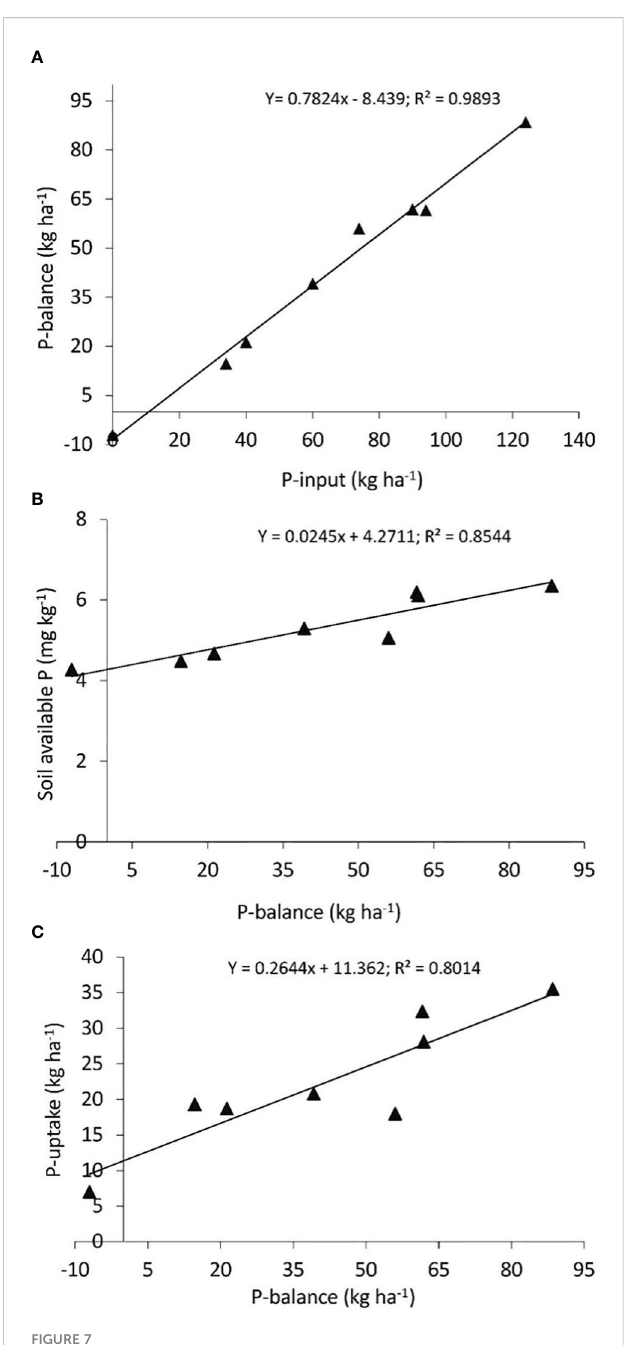
FIGURE 7 Simple linear regression analysis shows the relationship of P balance (PB) with P input (A) , soil (plant)-available P as AB-DTPA with PB (B) , and P uptake with PB (C)